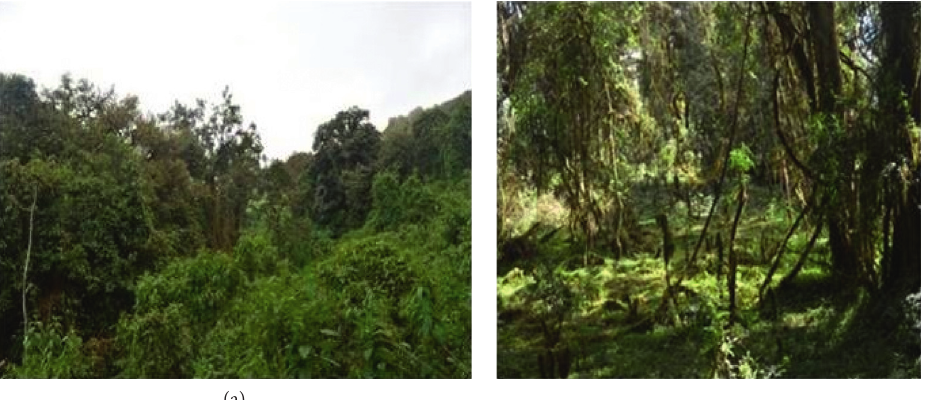
Figure 2: The intact moist Afromontane habitat at Nensebo forest, Southern Ethiopia (photo: Zerubabel Worku, 2018).